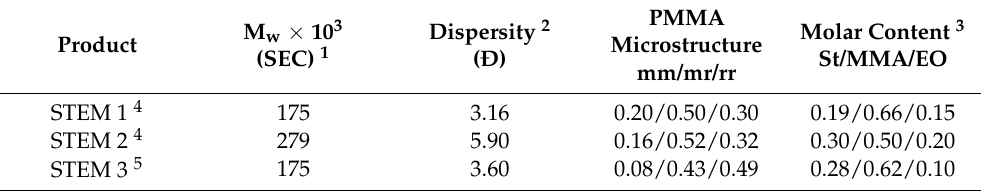
Table 2. Molecular mass and composition of ABC terpolymers depending on mode of monomer addition.